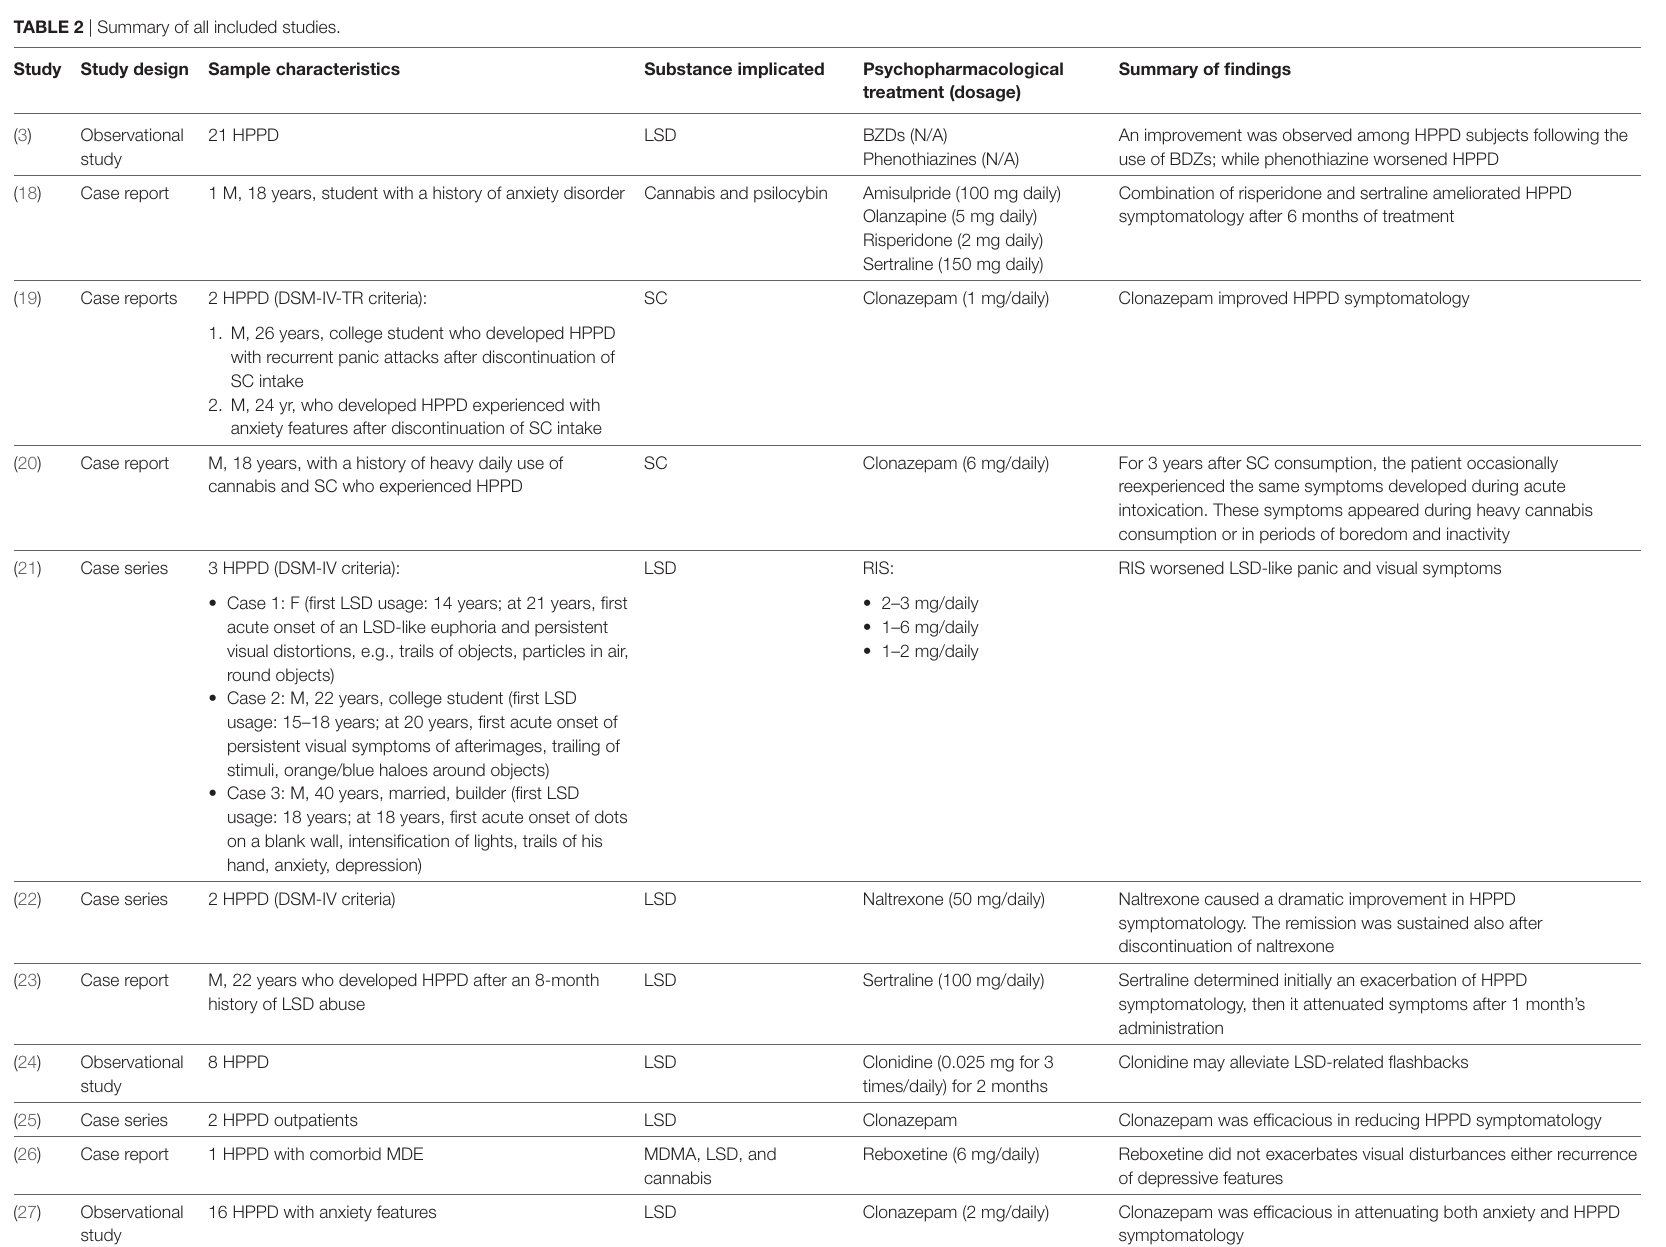
TAble 2 | Summary of all included